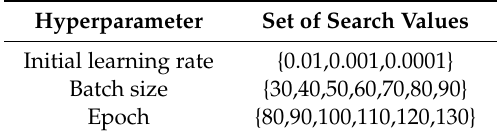
Table 7. Searching sets of hyperparameters to be